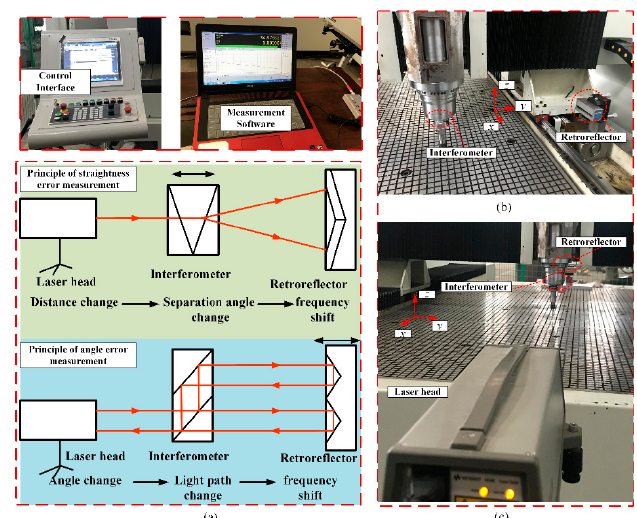
Figure 7. Principle of optical scale measurement positioning errors.